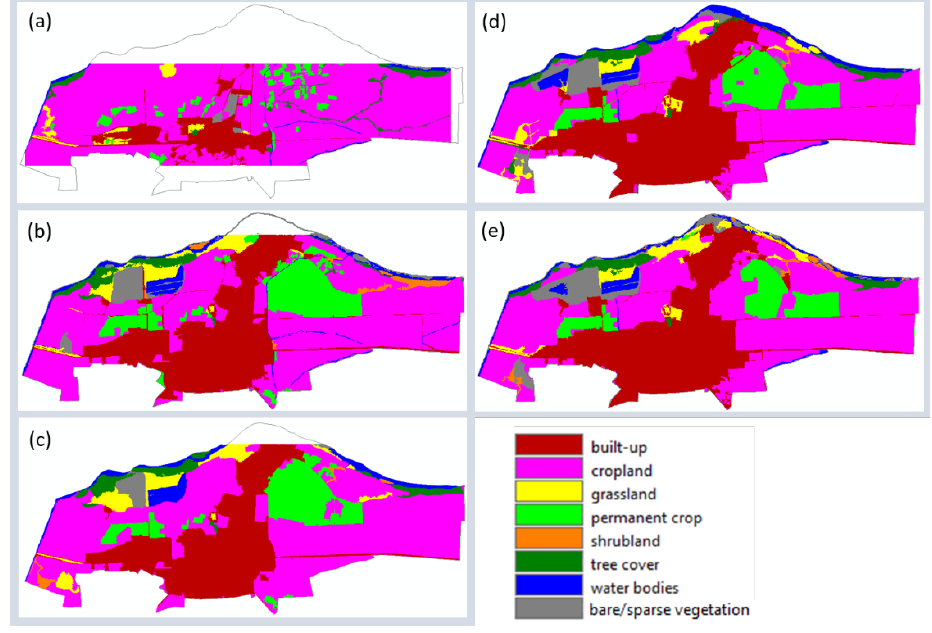
Figure 18. Land cover maps of Stamboliyski in: ( a ) 1952, ( b ) 1965, ( c ) 1968, ( d )1975, ( e )1980. Table 10. Temporal evolution of the LULC classes in Stamboliyski from 1952 to 1980 (in absolute numbers and percentages).